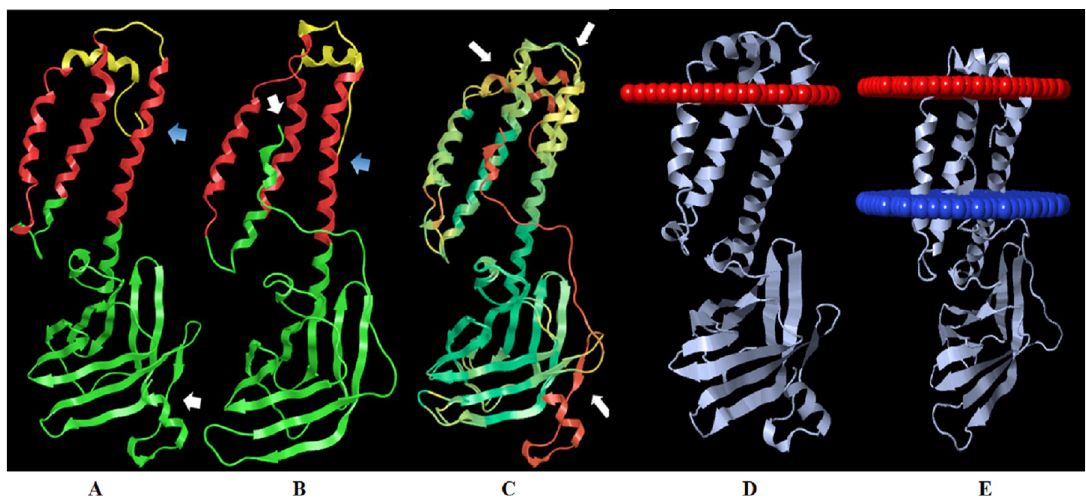
Fig 2. Predicted 3D models of the CV777 M and 2013MMV M proteins, generated with Robetta. A) CV777 M protein model. B) 2013MMV M protein model. The transmembrane region is shown in red. The regions outside the viral membrane are shown in yellow. The globular region is shown in green. The blue arrows point to the N-terminal end and the white arrows point to the C-terminal end. C) Overlapping of the 3D models of CV777 M and 2013MMV M proteins. The red areas correspond to the highest RMSD value, while the green areas correspond to the lowest RMSD value. The white arrows indicate the sites with the highest RMSD, corresponding to the loops and to the N- and C-terminal ends. D) 3D model of CV777 M protein on a theoretical lipid layer obtained from the OPM server. The program added red pseudoatoms to mark the extracellular hydrophobic boundary of the lipid bilayer. E) 3D model of 2013MMV M protein on a theoretical lipid bilayer obtained from the OPM server. In this case, the server added red and blue pseudoatoms to mark the extracellular and intracellular hydrophobic boundaries of the lipid bilayer,